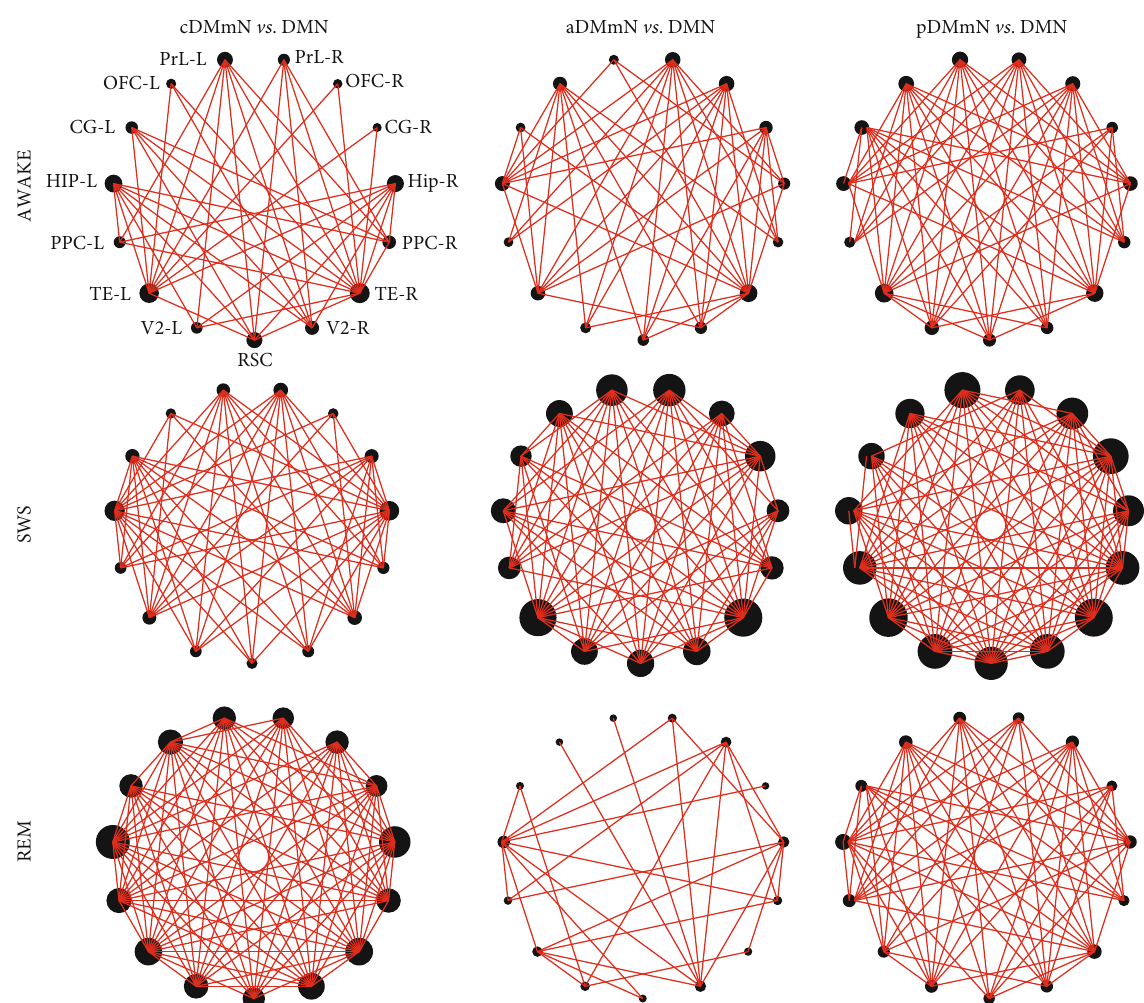
Figure 2: Comparisons between CAMP networks and the original DMN in di ff erent states of consciousness. The red lines indicate signi fi cantly increased FC with p < 0 : 0002 (FWE